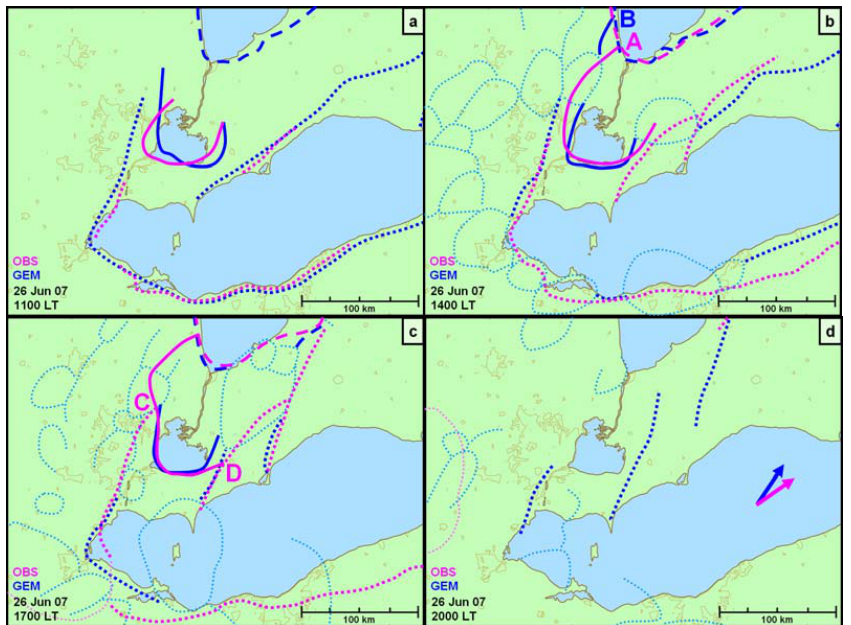
Figure 9. Same as in Fig. 8 but for June 26 th , 2007. Dotted lines mark surface gust fronts due to deep moist convection (light magenta for observations and light blue for modeled). Locations A–D are discussed in the text.